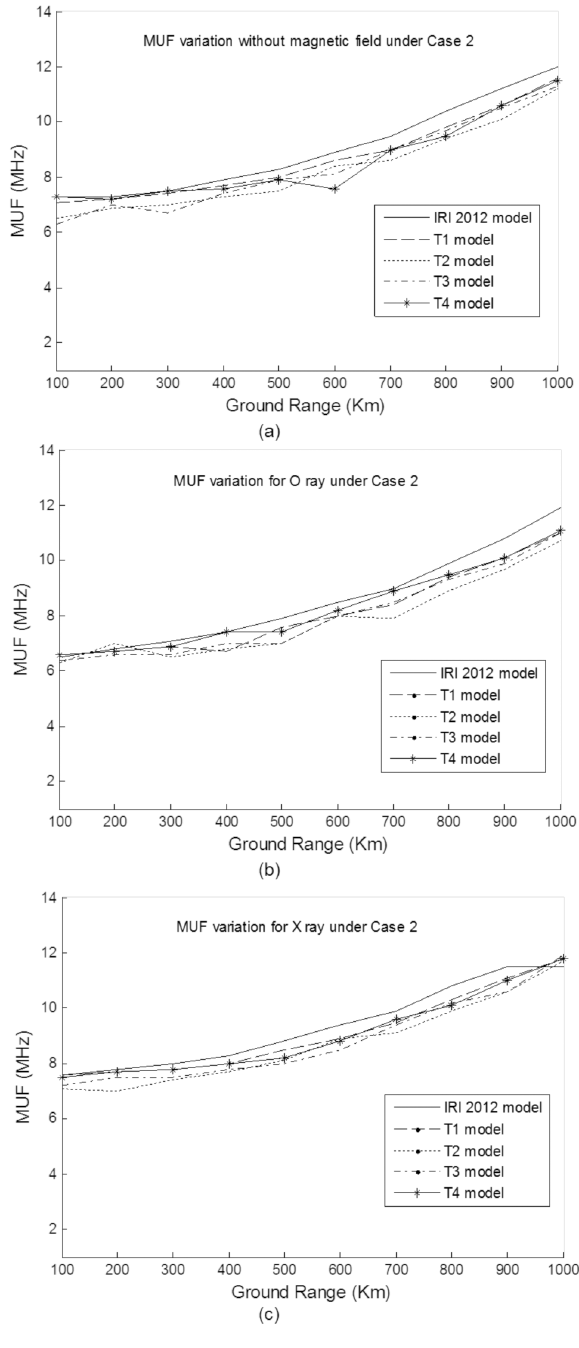
Figure 11. MUF comparison under Case 2, (a) without influence of magnetic field, (b) for O mode under influence of magnetic field, (c) for X mode under influence of magnetic